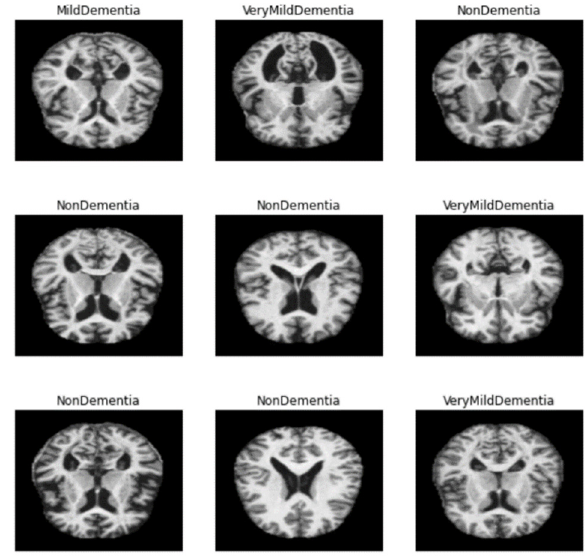
Figure 1. Categories of dementia level in dataset.